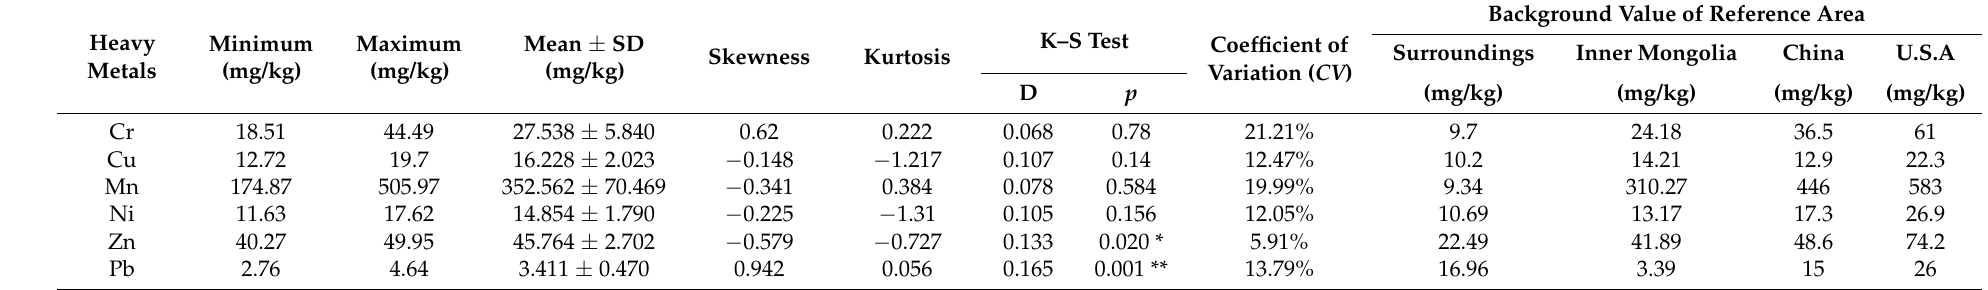
Table 1. The statistical features of concentrations of heavy metals in soil of mining